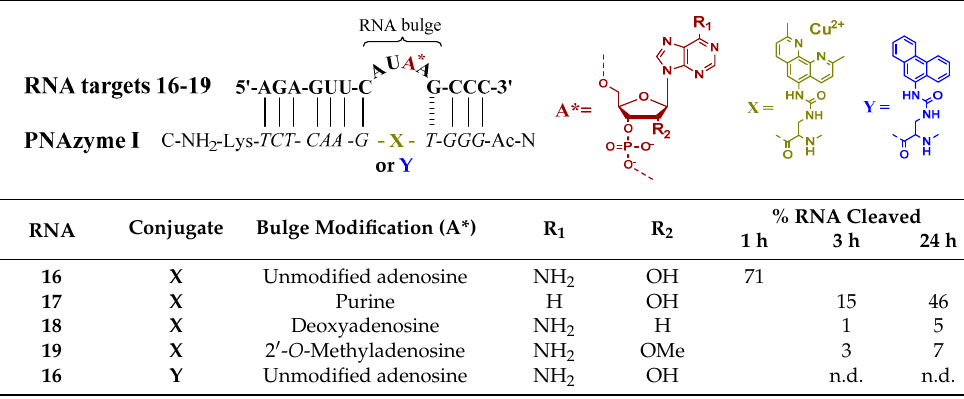
Table 2. The extent of cleavage of 4-nucleotide bulge-forming reference RNA 16 and modified RNA sequences 17 – 19 after incubation in the presence of equimolar PNAzyme I over a period of 1 h, 3 h and 24 h.